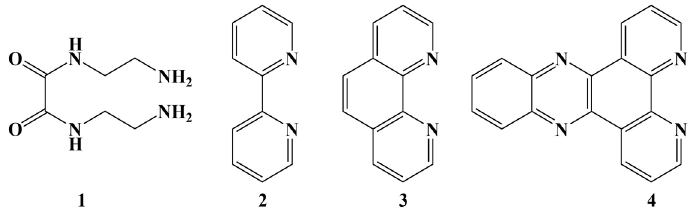
Figure 36. The ligands of the complexes presented in [130].